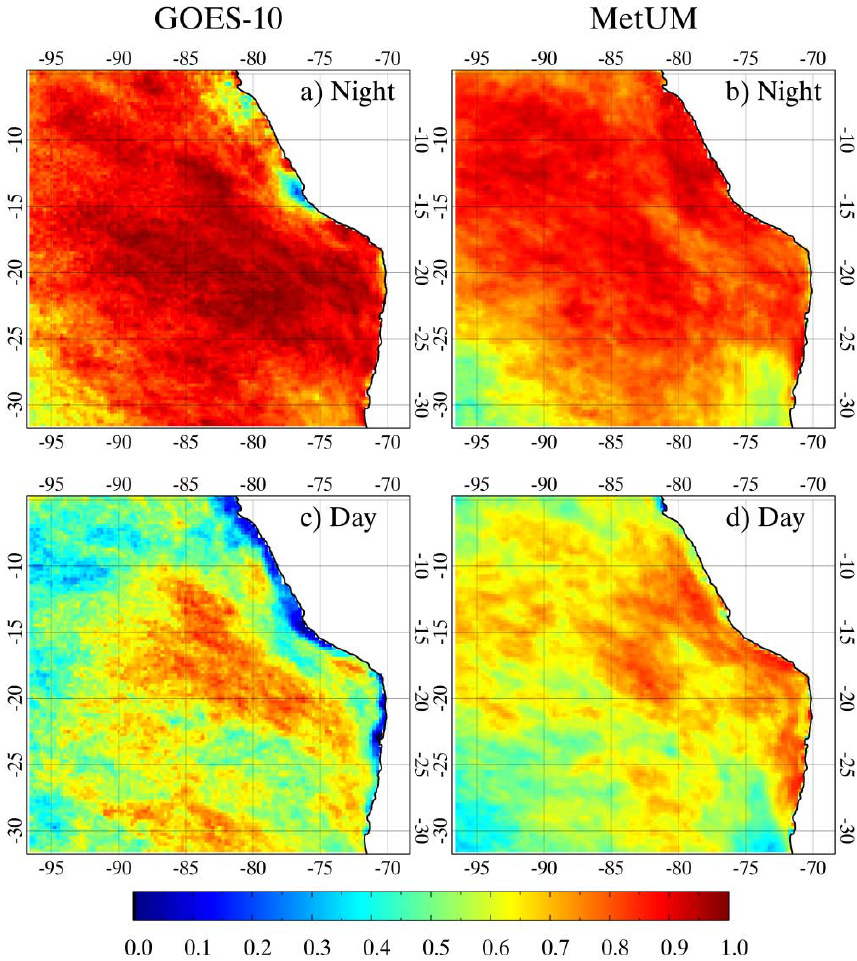
Fig. 6. Mean low cloud fraction at 07:30UTC (night) and 19:30UTC (day) for the period 14 October to 19 November 2008. GOES-10 data are shown in panels (a) and (c) and the MetUM forecast data in panels (b) and (d)